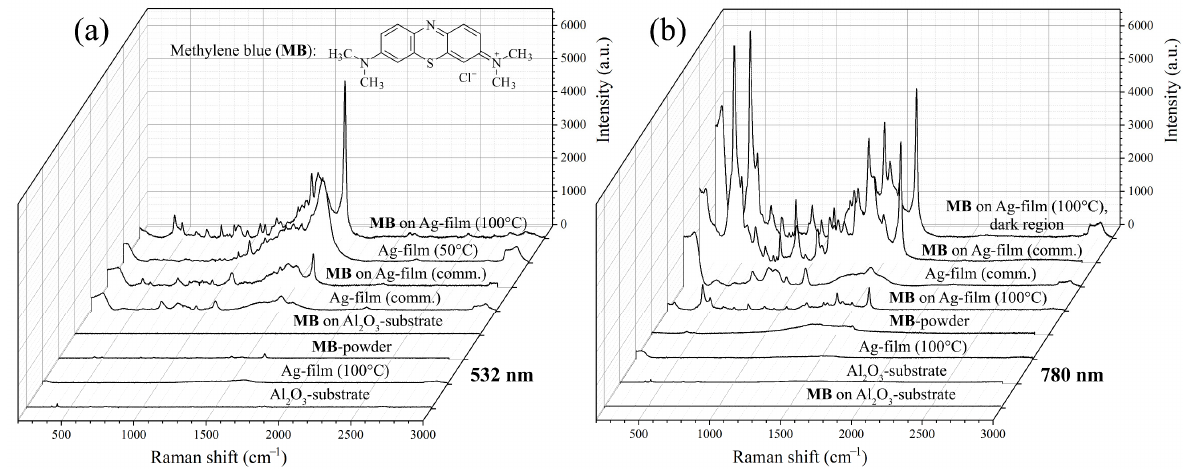
Figure 9. Raman and SERS spectra of the materials studied, obtained using lasers with an emission wavelength of 532 ( a ) and 780 nm ( b ); the indicated temperature values refer to the conditions of additional heat treatment of the Ag film in air.